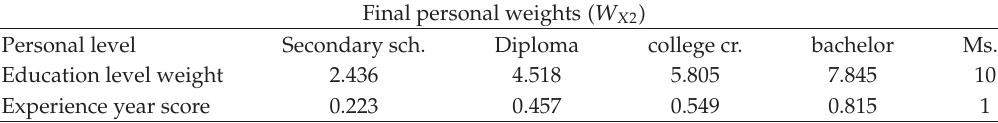
Table 4: Final fuzzy weights of personnel.